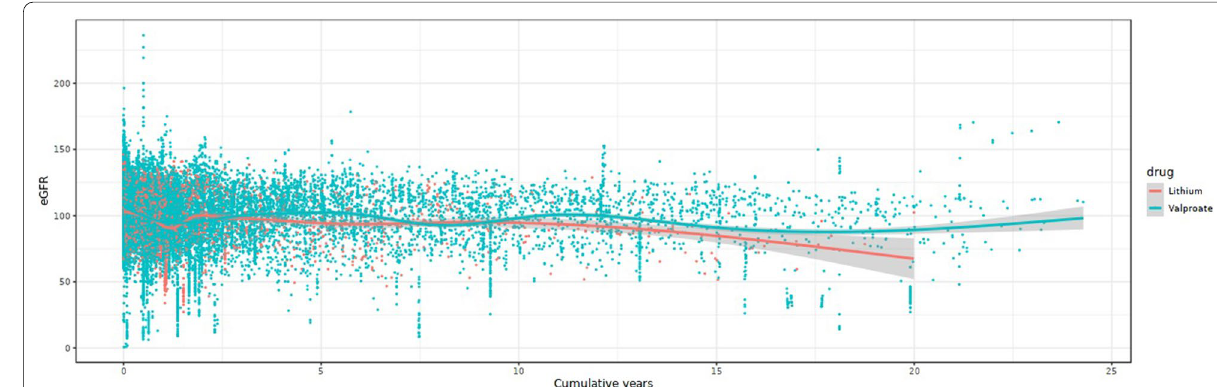
Fig. 2 Scatter plot of eGFR over follow-up period